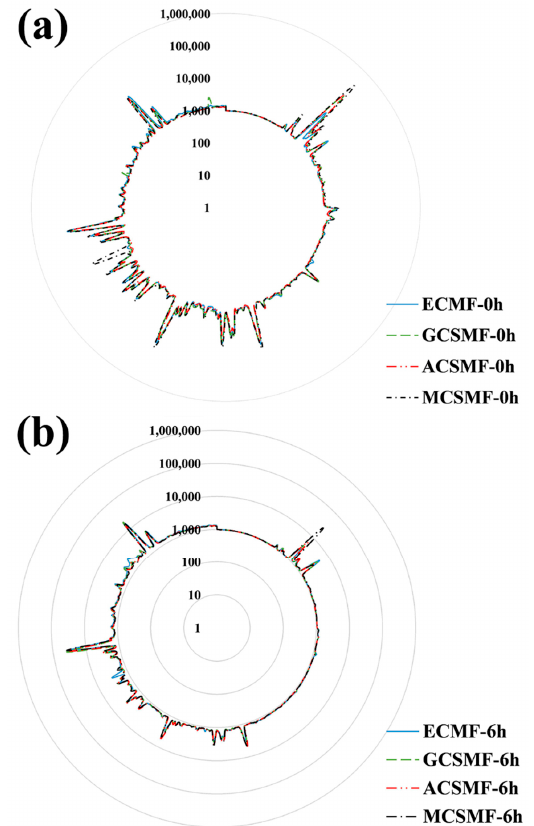
Figure 7. ( a ) Comparison of E-nose between EC microcapsules scented cotton fabric (ECMF), EC/SiO 2 hybrid microcapsules by GPTES-modified scented cotton fabric (GCSMF), EC/SiO 2 hybrid microcapsules by APTES-modified scented cotton fabric (ACSMF), and EC/SiO 2 hybrid microcapsules by MPTES-modified scented cotton fabric (MCSMF); ( b ) comparison of E-nose between ECMF, GCSMF, ACSMF, and MCSMF after treatment at 120 °C.